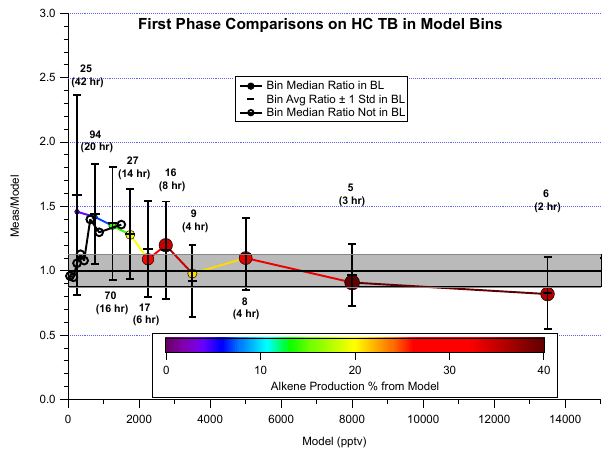
Fig. 10. TDLAS measurement/model ratios for all locations during first phase on hydrocarbon time base (HC TB) binned by model values as a function of model values. Each point displays the bin average ratio (horizontal lines), the ± 1 standard deviation for this bin (bars), and the median ratio (circles). The filled colored points are in the boundary layer (BL, radar altitude < 2km) while the open black circles are outside the BL. Each BL point is colored and sized by the bin median alkene production percentage of CH 2 O from the model. The number of data points in each bin is given by the top number next to each point while the bottom number represents the binned median value for the photochemical age determined from the ratio of 2-butyl nitrate to butane (see Perring et al., 2010) employing the instantaneous measured OH concentrations. The gray shaded region represents the median for the combined measurement and model 2 σ uncertainty limits ( ± 13%) in the boundary